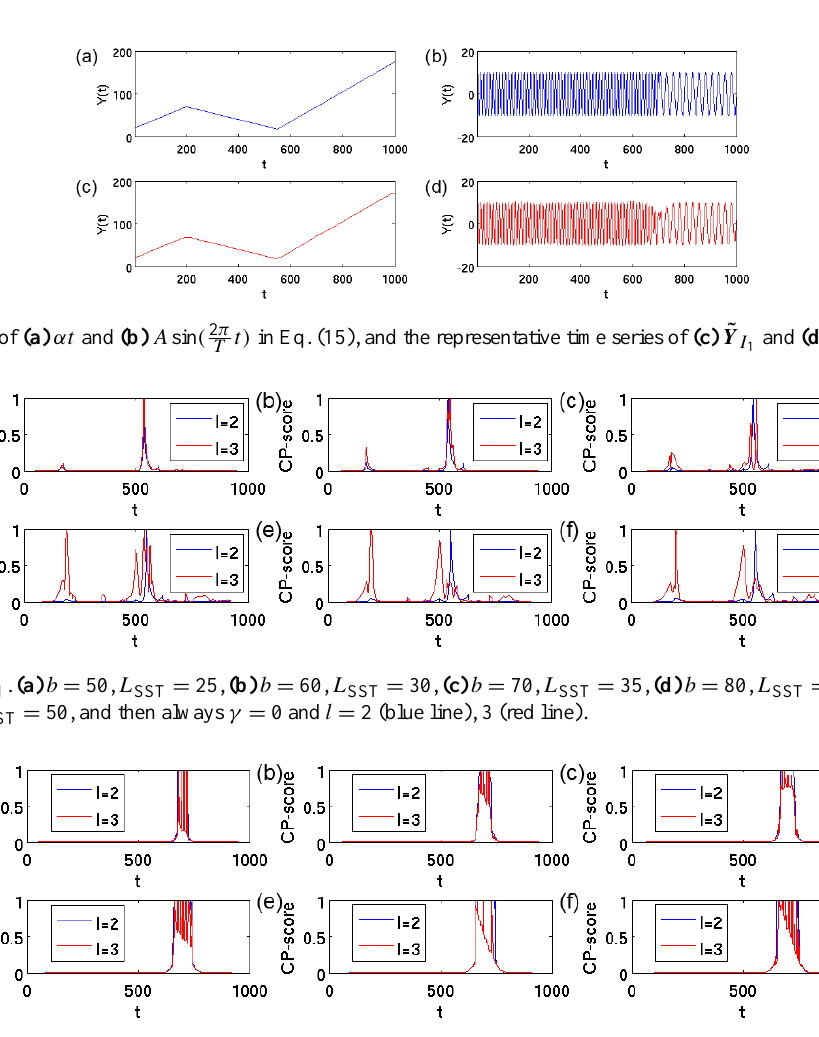
t ) in Eq.(15), and T and (d) ~Y I . 1 2